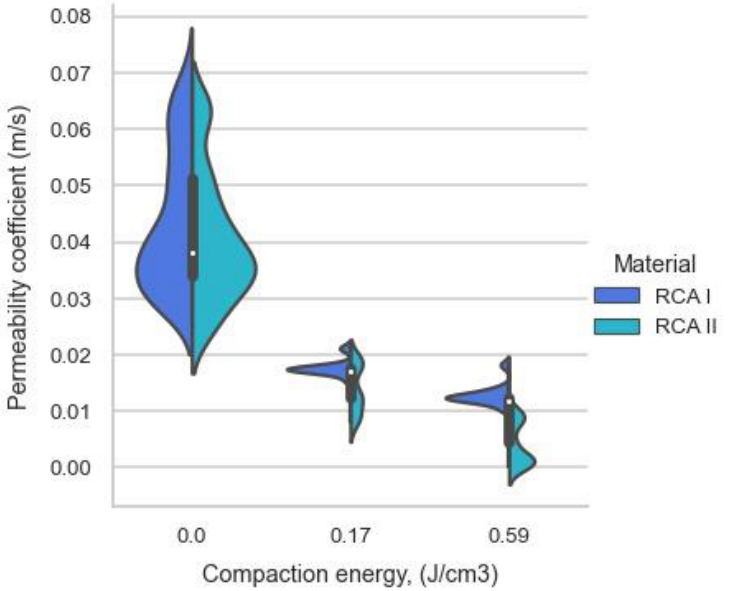
Figure 4. The relationship of the permeability coefficient results to compaction energy in the context of the tested material.